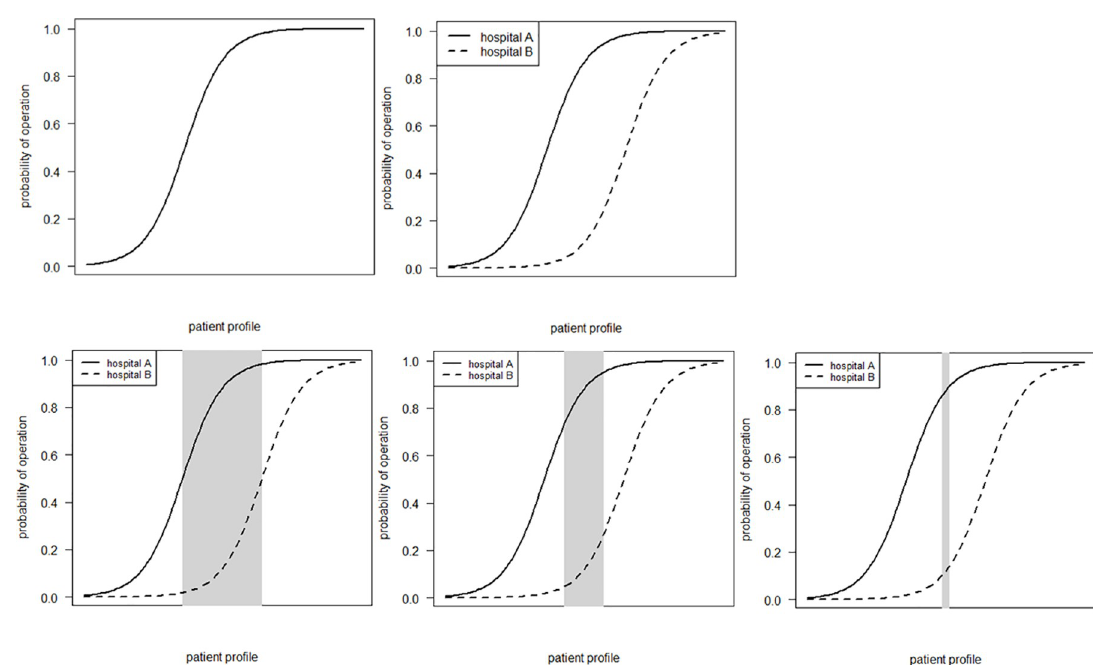
Fig 2. Patient profile continuum and confounding. Patient profile is a continuum, on the one end all patients receive nonoperative treatment and on the other end all patients receive operative treatment, this can differ per country. By zooming in on patients with a similar profile, confounding will be mitigated to a large